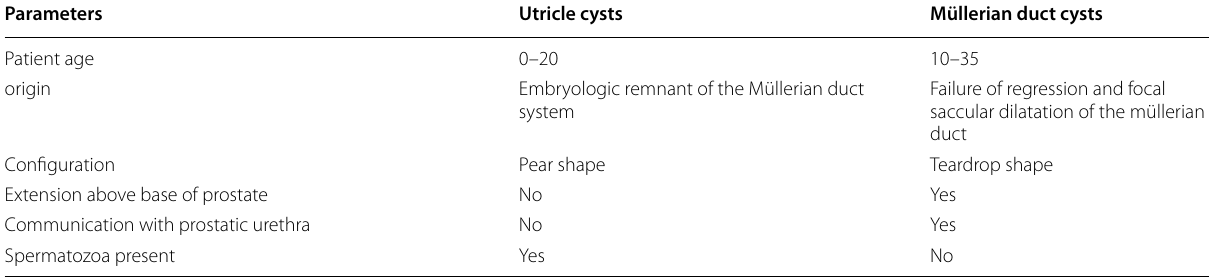
Table 2 Prostatic utricle cysts versus Müllerian duct cysts (source: Reference